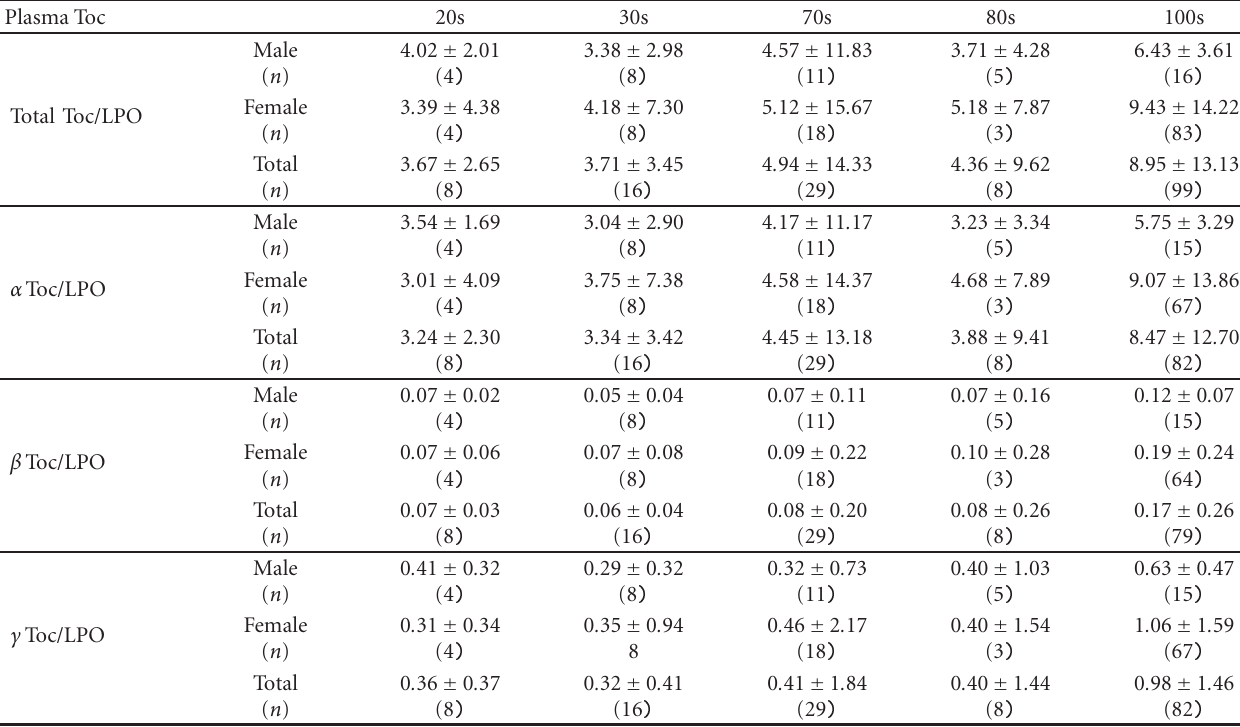
Table 5: Average plasma tocopherol fractions/LPO across age